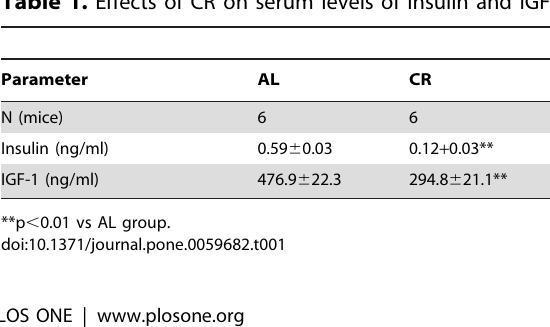
Table 1. Effects of CR on serum levels of insulin and IGF-1.